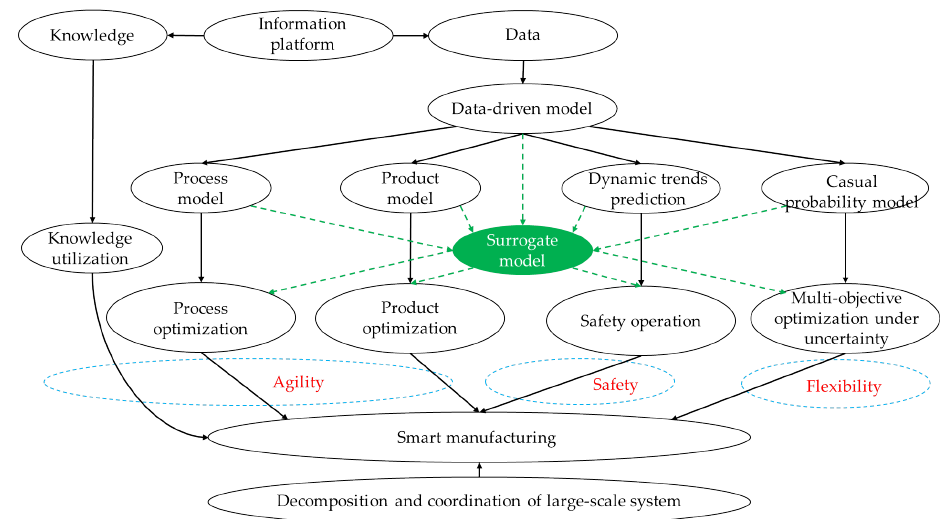
Figure 11. Components of smart processing in the oil industries